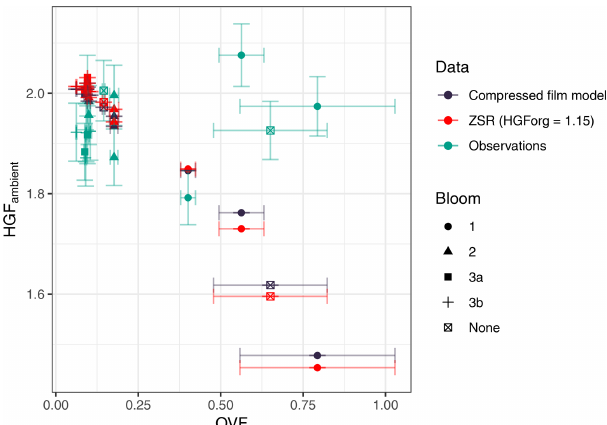
Figure 14. Ambient HGF modelled using the compressed film model (green) as a function of OVF, modelled using the ZSR as- sumption (light blue) and observed (dark blue). Compressed film model output is for the case where lipid and protein fraction (com- puted from functional group measurements) can partition to the par- ticle surface. The ZSR model used an organic HGF of